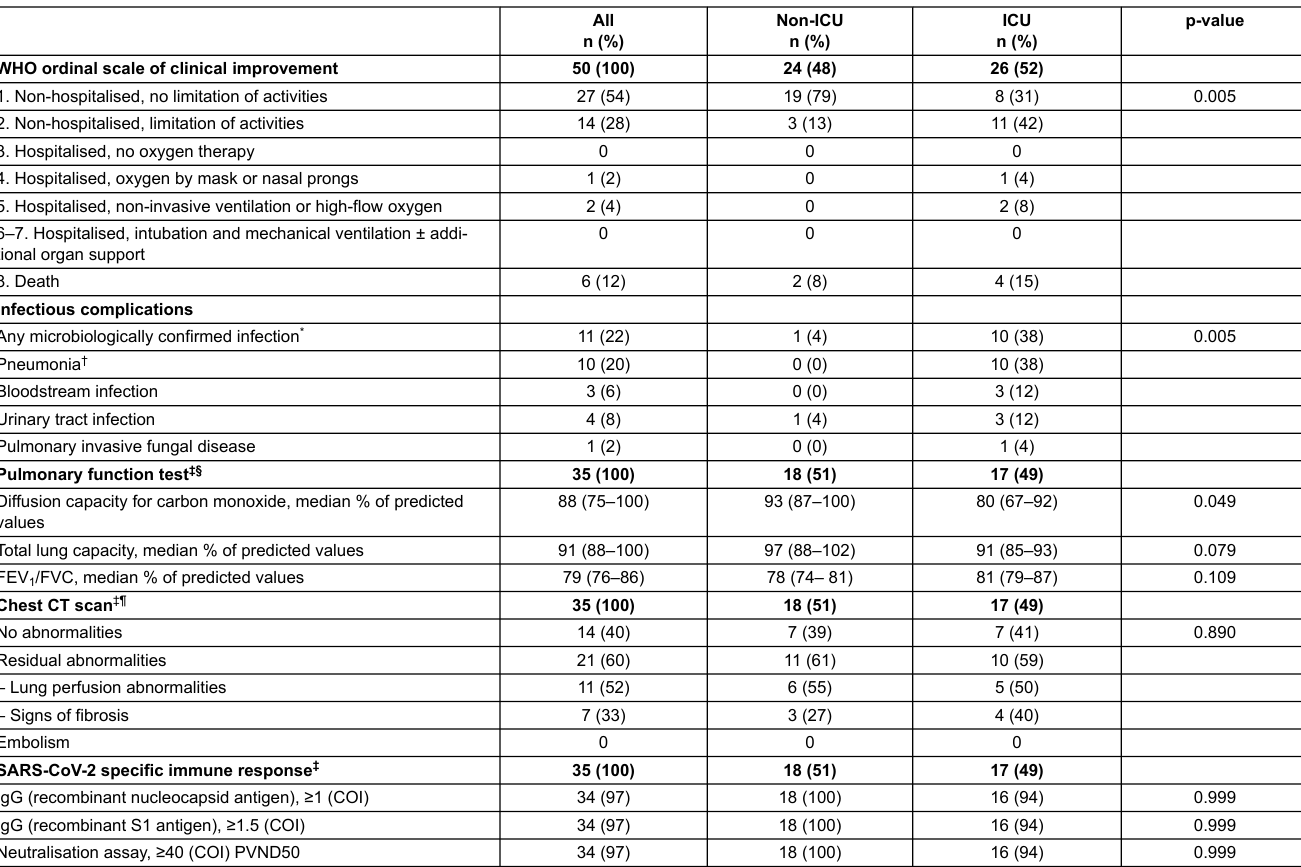
Table 2: 90-day adverse and infectious events clinical, immunological, pulmonary and radiological outcome of patients treated with tocilizumab.